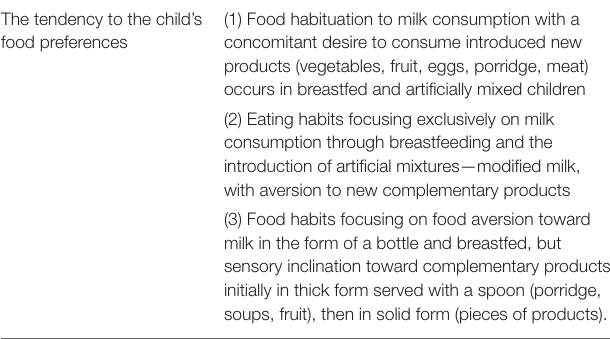
TABLE 2 | Examples of sensory diversity among children. The tendency to the child’s food